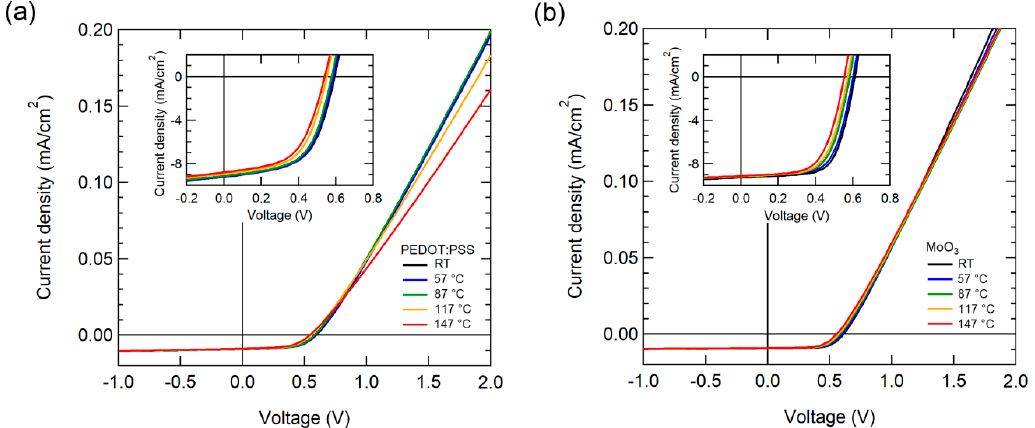
Figure 2. Current density (J)-voltage (V) characteristics of OSCs with various temperatures using ( a ) PEDOT:PSS and ( b ) MoO 3 as HEL under 1-sun illumination. The inset illustrates the enlarged fourth quadrant area of the J-V curve. Table 1. Performance parameters of OSCs as a function of operating temperature using PEDOT:PSS and MoO 3 as HEL under 1-sun illumination.